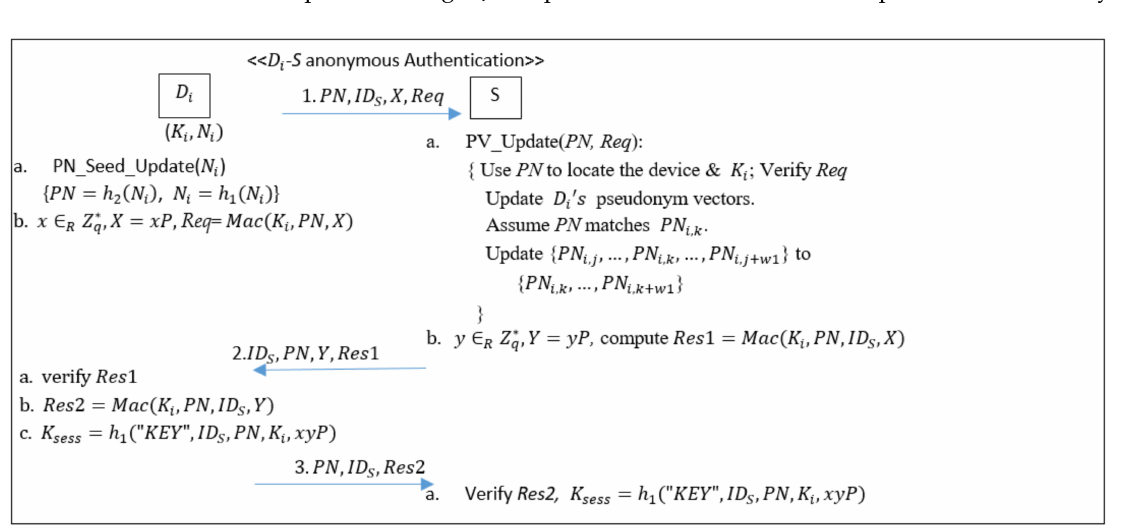
Figure 3. D i -S’s level-1 D2S authentication